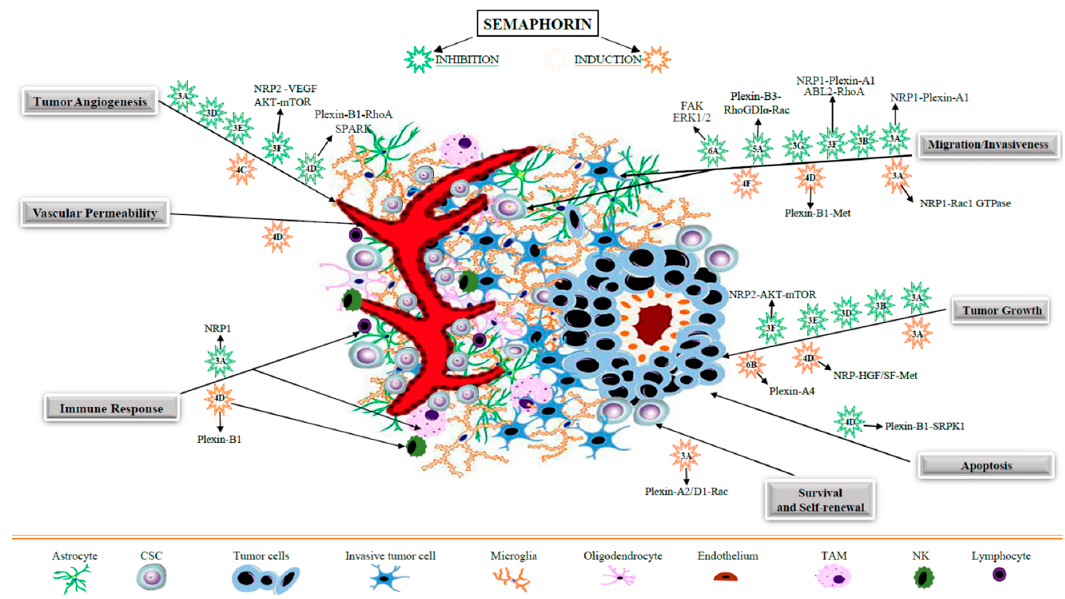
Figure 2. Semaphorin signals regulating GBM cells and the tumor microenvironment. The figure summarizes pro- or anti-tumorigenic activities mediated by diverse semaphorins controlling GBM progression by the regulation of diverse cell populations in the tumor microenvironment. Divergent semaphorin functions may be explained by specific plexin–neuropilin (NRP) receptor complexes or intracellular e ff ector pathways (also indicated, as reported in literature).